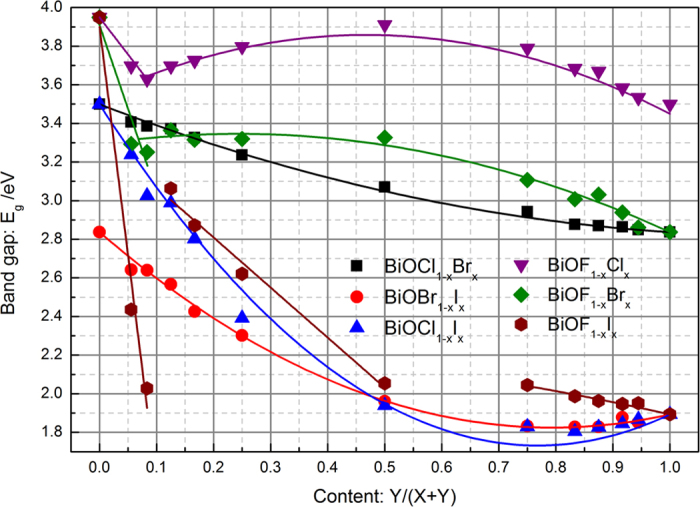
Band gap of BiOX1−xYx solid solutions as a function of content x.